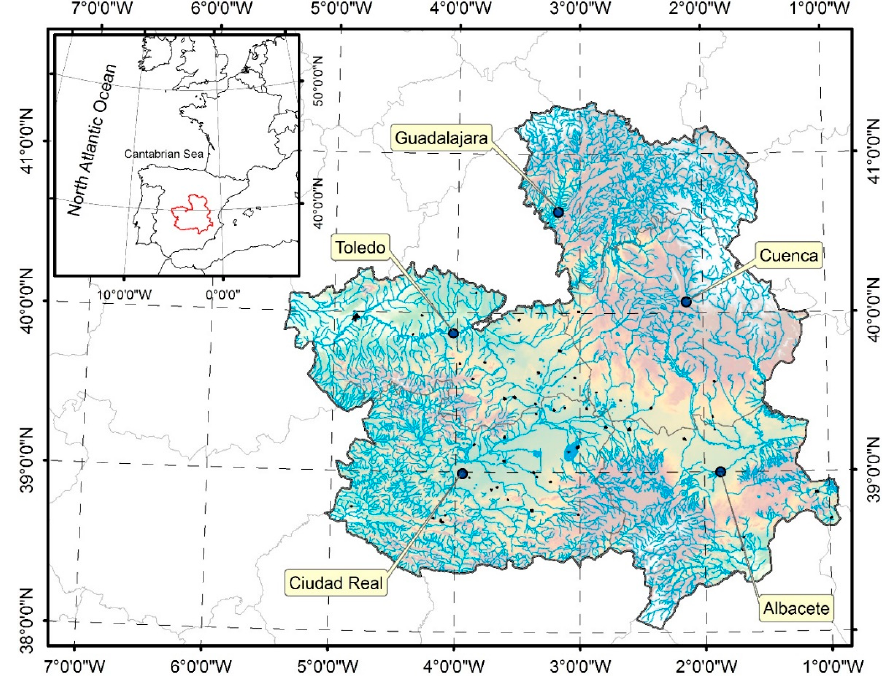
Figure 1. Location map of the autonomous community of Castilla-La Mancha. Dark blue circles show the location of each province capital city, and the black dots show the location of major towns.